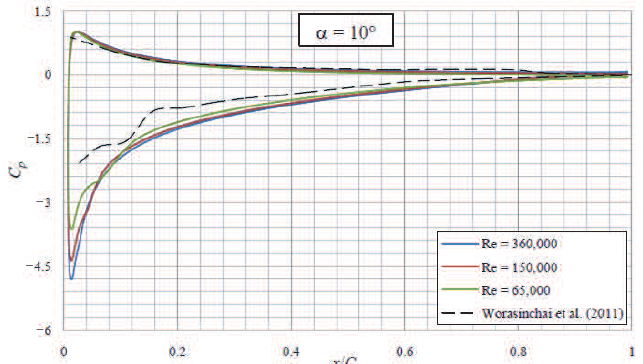
Figure 25. Pressure coefficient along airfoil as a function of distance from leading edge for α = 10 ◦ .